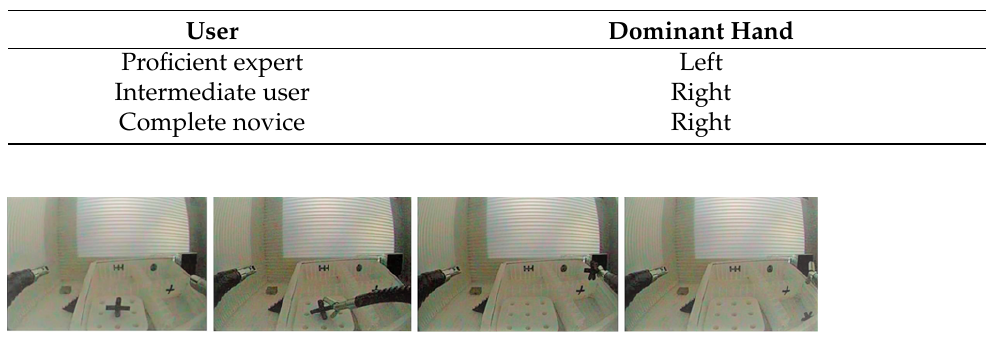
Table 1. User Information